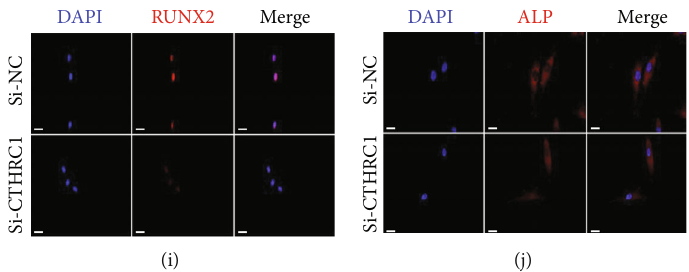
Figure 6: CTHRC1 enhanced the osteogenic di ff erentiation capacity of PDLSCs. (a) The result of qRT-PCR showed that transfection e ff ect of Si-2 was better. ∗∗ P < 0 : 01 . (b) QRT-PCR showed the expression of osteogenesis-related genes ( ALP , RUNX2 , and OSX ) downregulated. ∗∗ P < 0 : 01 . (c) Western blot analysis of osteogenic markers in PDLSCs transfected with Si-CTHRC1. (d) Relative grayscale analyses of (c). ∗ P < 0 : 05 , ∗∗ P < 0 : 01 . (e, f) 7 days after mineralization, ALP staining and ALP activity analysis were performed ( scalebar = 100 μ m ). ∗∗ P < 0 : 01 . (g, h) Results of ARS staining and CPC assay at day 14 ( scalebar = 100 μ m ). ∗∗ P < 0 : 01 . (i, j) Immuno fl uorescence assay revealed that the protein expression of RUNX2 and ALP was downregulated in Si-CTHRC1 group as compared with controls ( scale bar = 50 μ m